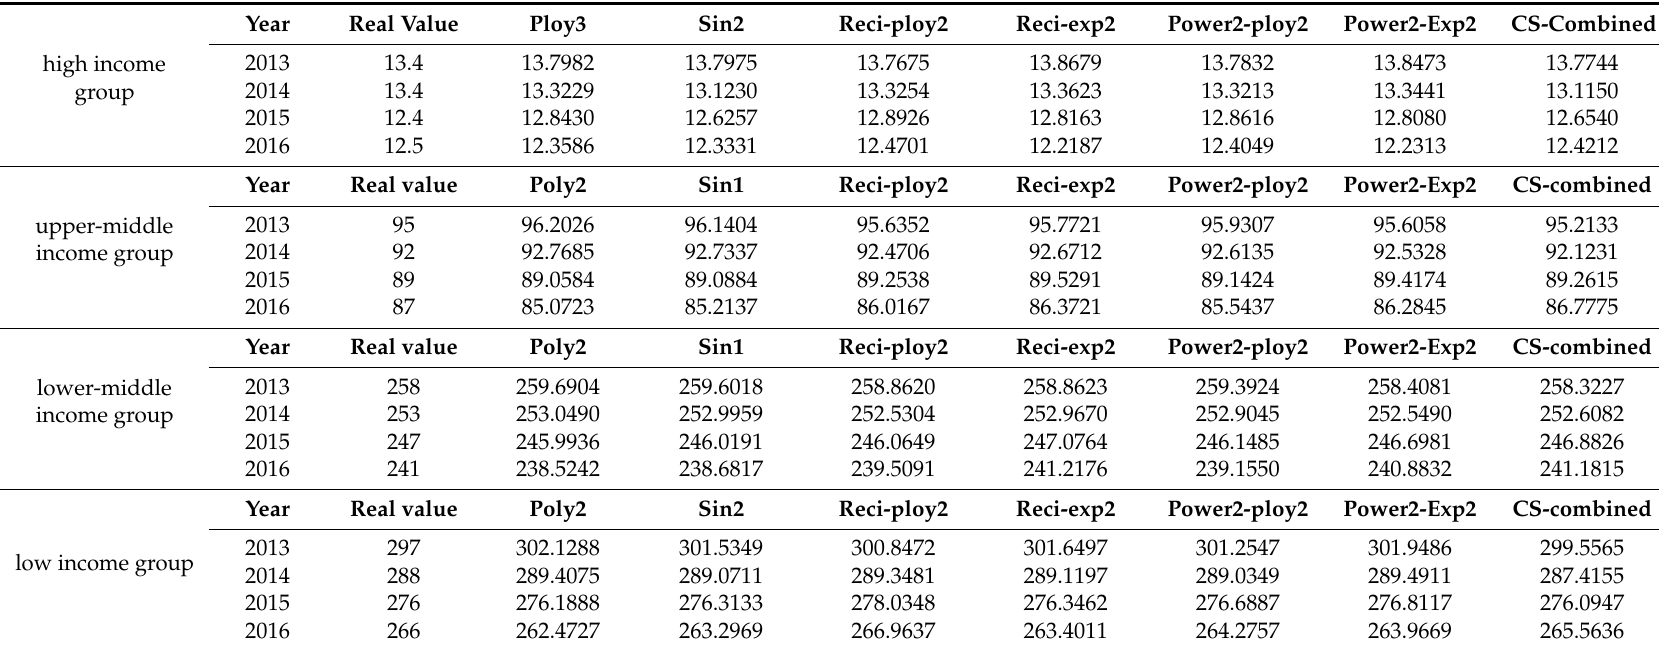
Table A1. Real values and forecasting values of the seven models for the four income